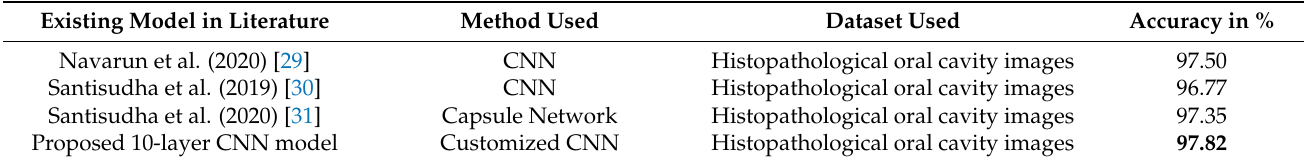
Table 6. Comparison of different existing models with the proposed